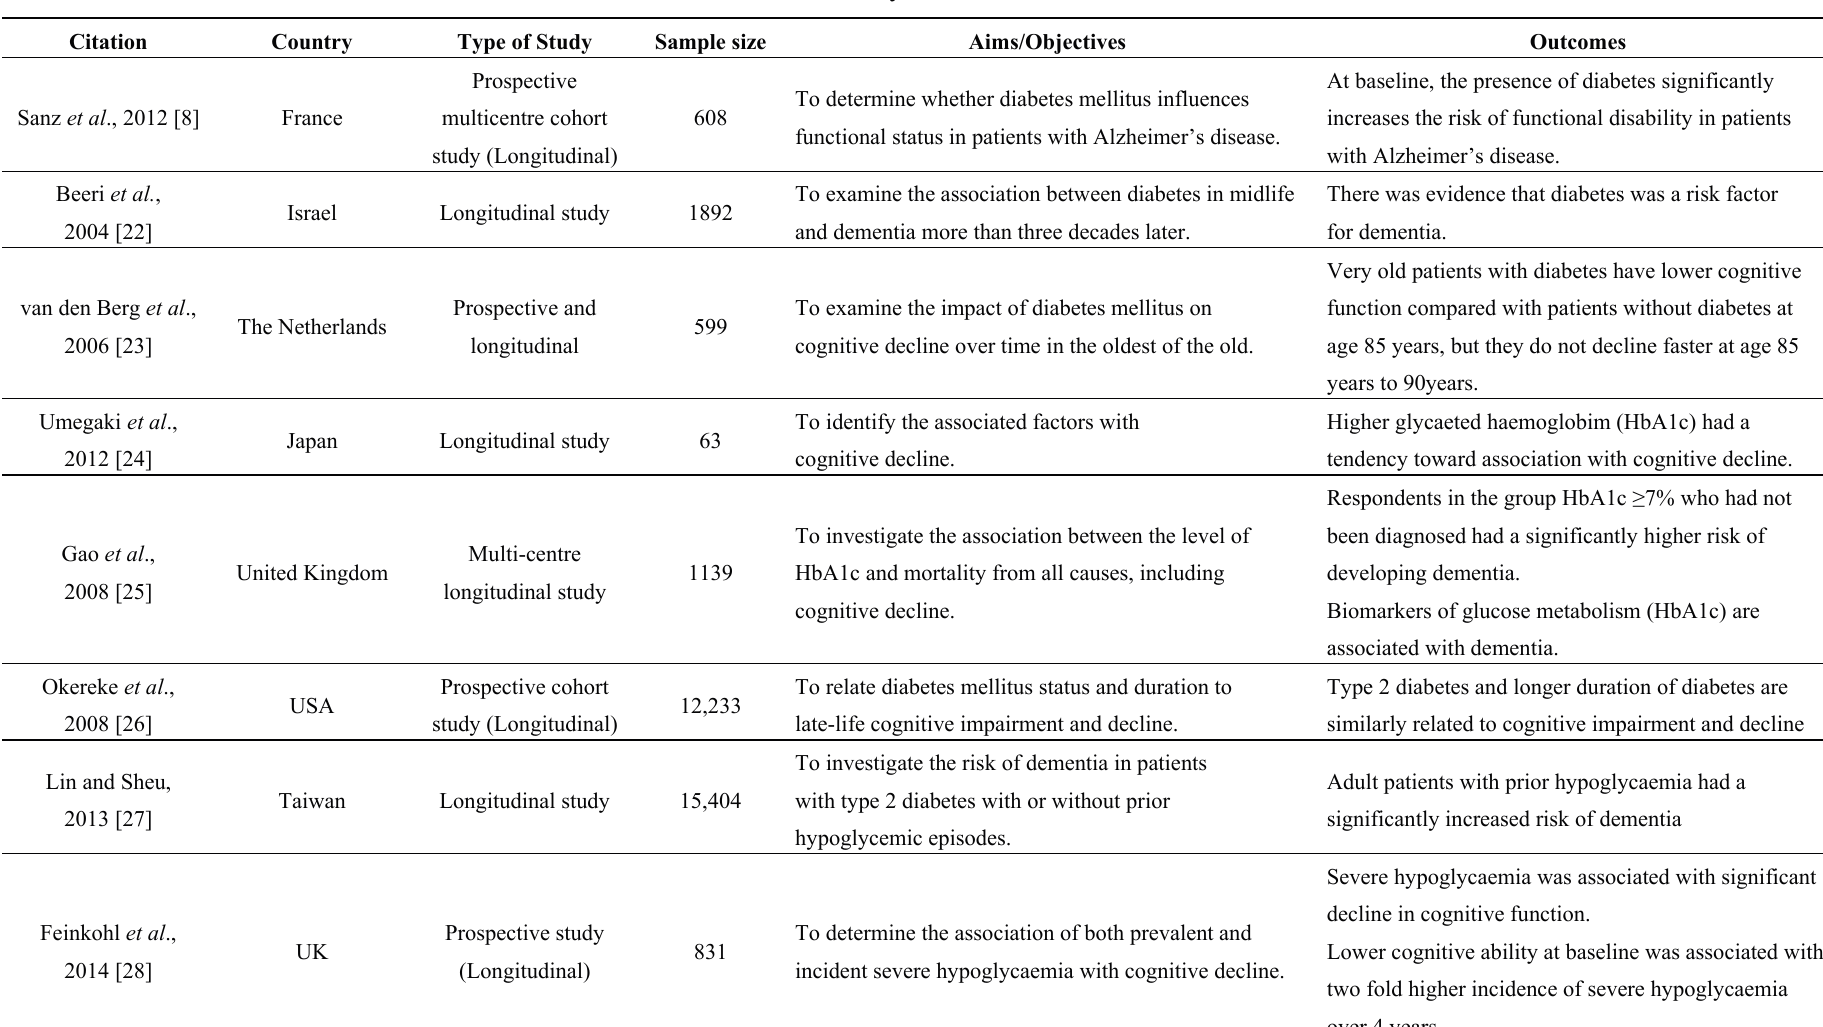
Table 1. Summary of Studies